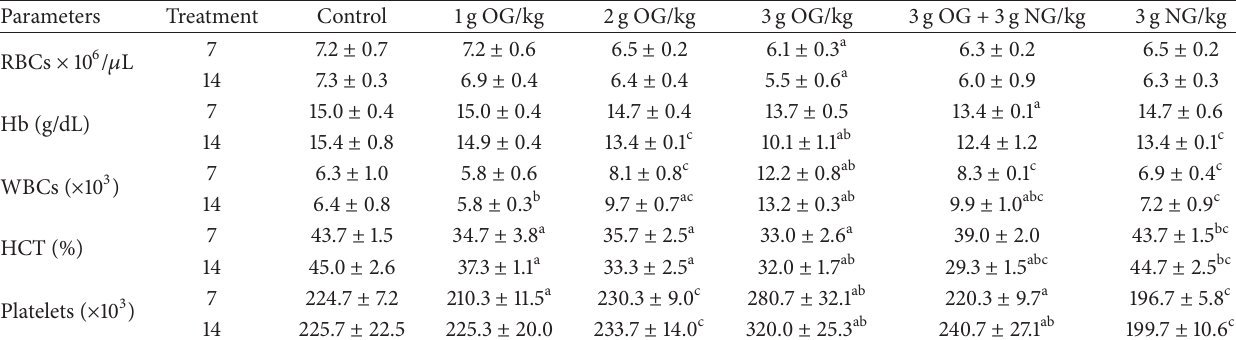
Table 4: Effects of coadministration of unoxidized and oxidized desi ghee on the changes in blood hematological values of rabbits. Parameters